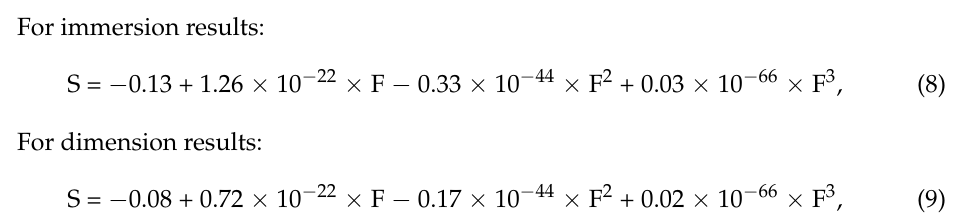
Figure 6. Dose dependence of swelling S of VHP ‐ 400 beryllium grade, reactor BOR ‐ 60, T irr = 420 °C, F = (5–8) ∙ 10 22 cm − 2 (E > 1 MeV) (imm.—immersion). Figure 7. Dose dependence of swelling S of cast Be, reactor HFR, T irr = 430–750 °C, F = (0.73–1.82) ∙ 10 22 cm − 2 (E > 1 MeV) (pyc.—pycnometry). 3.3. Microstructure of Irradiated Beryllium and Titanium Beryllide A comparison of the radiation ‐ induced microstructure of the HE ‐ 56 beryllium grade irradiated at 70 and 200 °C shows a difference between them concerning a bubble formation rate. After irradiation at 70 °C, helium bubbles are practically absent in the